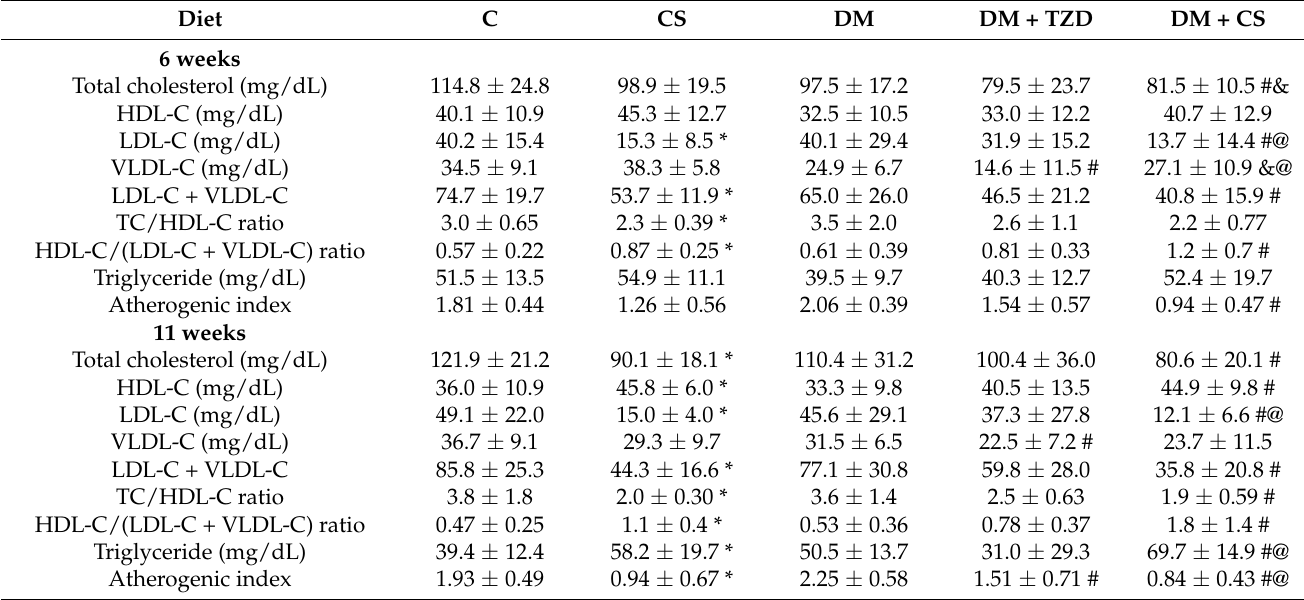
Results are expressed as mean ± SD for each group (n = 8). The significant difference ( p < 0.05) was analyzed by one-way ANOVA and two-tailed Student’s t -test. *: versus C; #: versus DM; &: versus CS; @: versus DM + TZD. C: control diet; CS: control diet +5% high